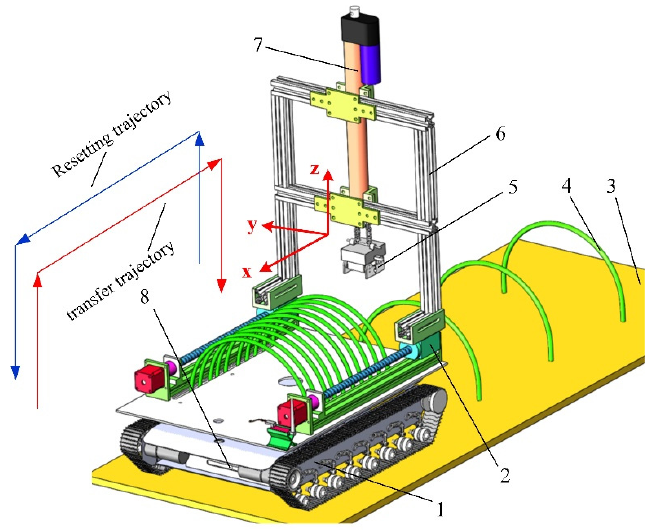
Figure 6. Simulation design diagram of the force feedback arch shed pillar cutting device. 1: walking